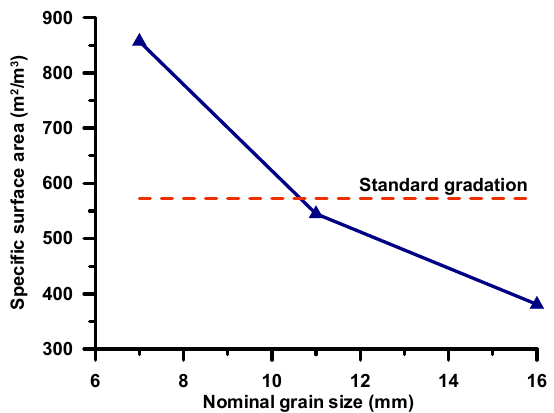
Figure 2. Relationship between grain size and the specific surface area (SSA) of aggregates.